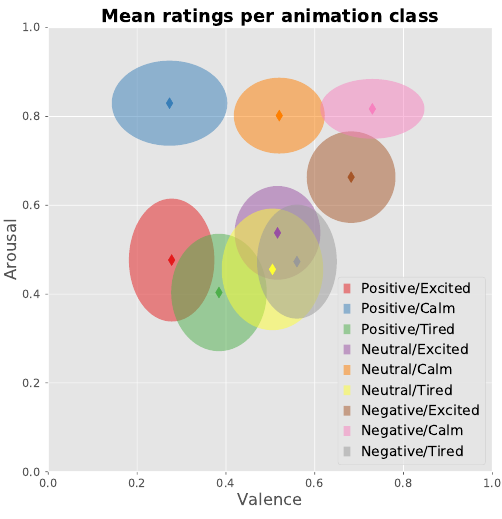
Figure 3: Mean ratings and standard deviations of valence and arousal per class. The space is divided in 9 classes as described in Table 1.